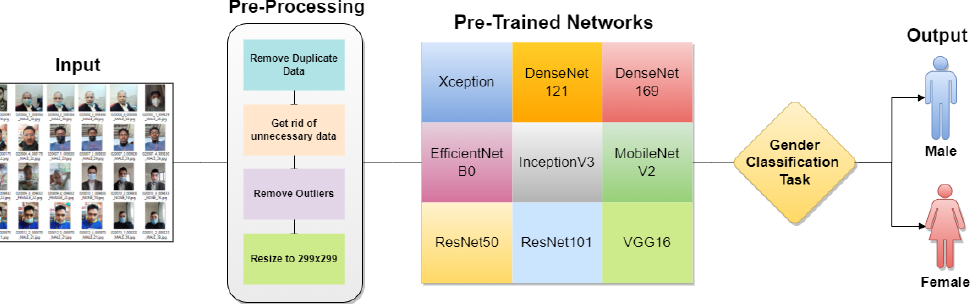
Figure 1. Workflow of proposed scheme.